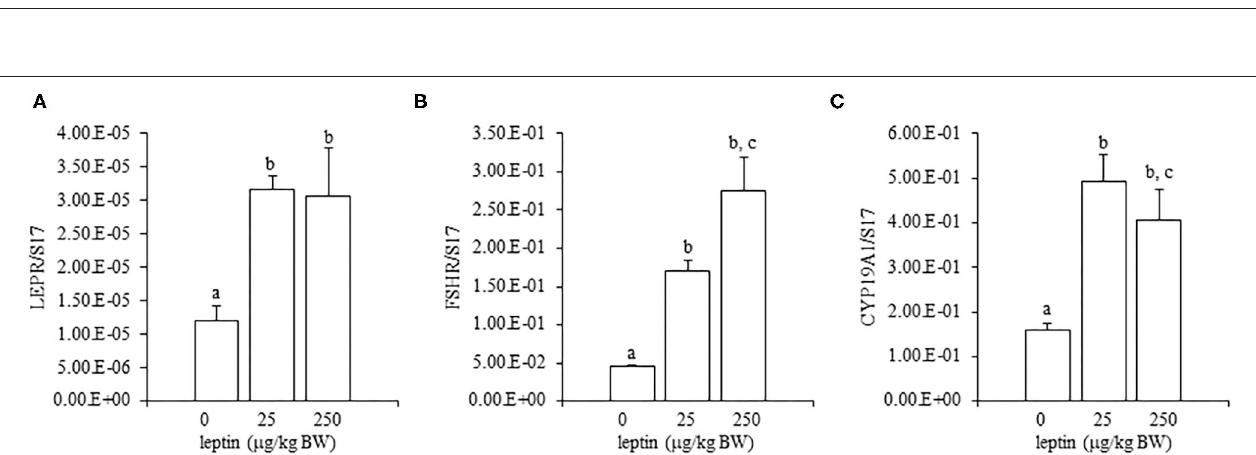
FIGURE 1 | The mRNA expression of LEPR (A) , FSHR (B) , and CYP19A1 (C) in the ovary in growing juvenile chicks. The data represent the mean ± SEM ( n = 4), and bars with different superscripts are significantly different.